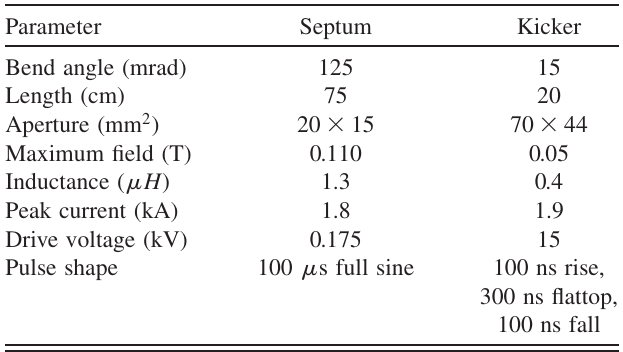
TABLE II. Booster injection pulsed magnet